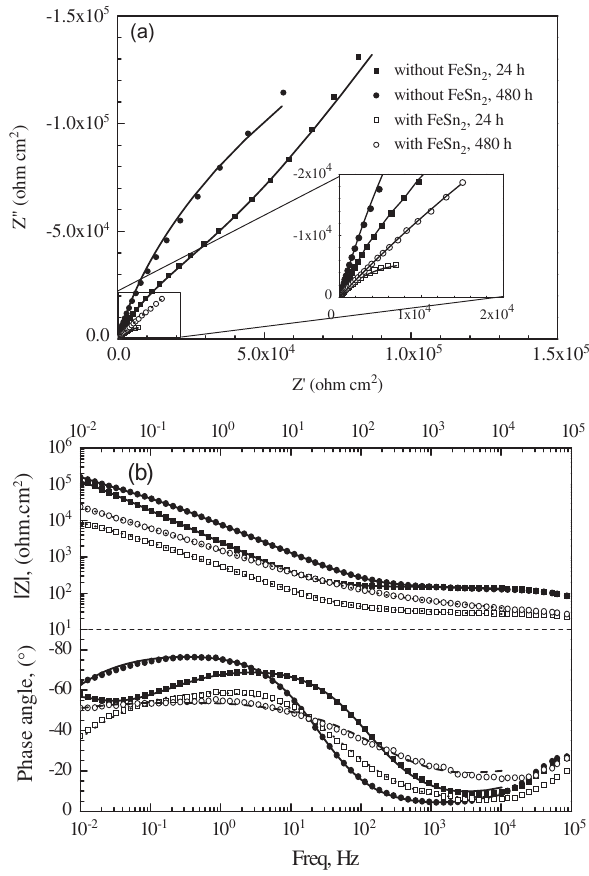
Figure 8: Electrochemical impedance spectra of oxide films in 3.5% NaCl solution after exposure to 300°C water for 24 h and 480 h: (a) Nyquist plot and high magnification at the left part of Nyquist plot (bottom insert), (b) Bode plot, the solid lines show the fit results.